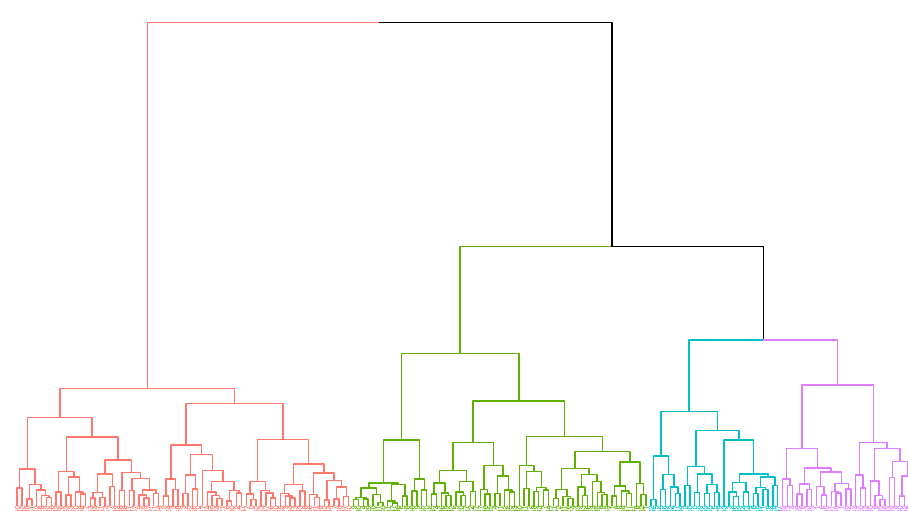
Figure 4. Dendrogram from the classification with Ward’s linkage algorithm (four clusters).